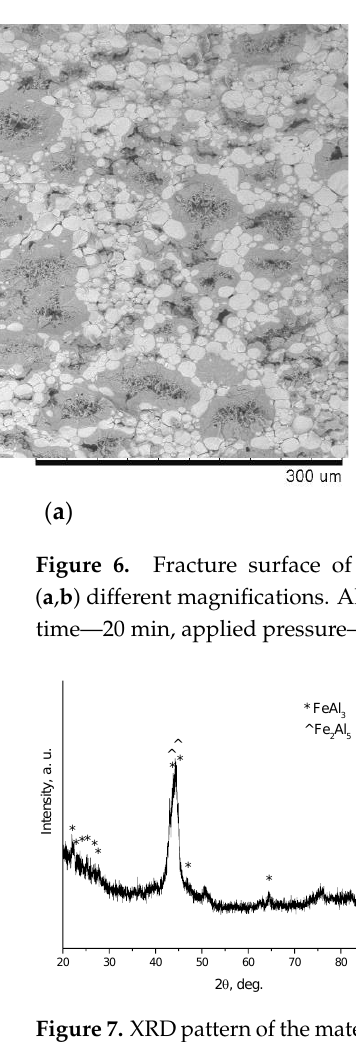
Figure 5. A core – shell particle in the microstructure of the composite formed during heating of the Al – 20 vol.% Fe 66 Cr 10 Nb 5 B 19 mixture in the hot press. HP conditions: temperature — above 660 °C, applied pressure — 40 MPa. BSE image.